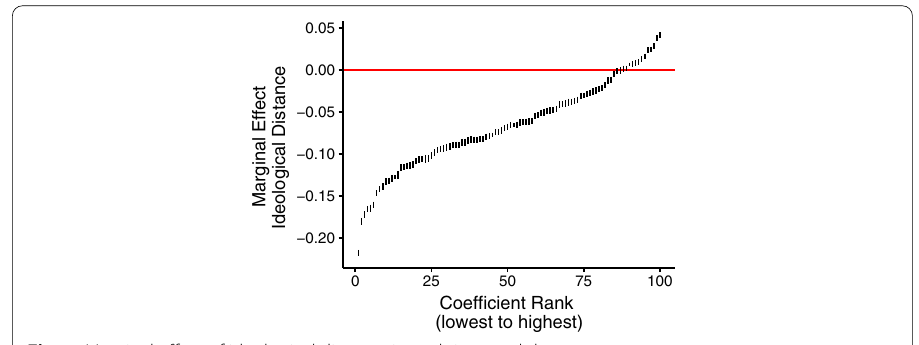
Fig. 5 Marginal effect of ideological distance in each imputed